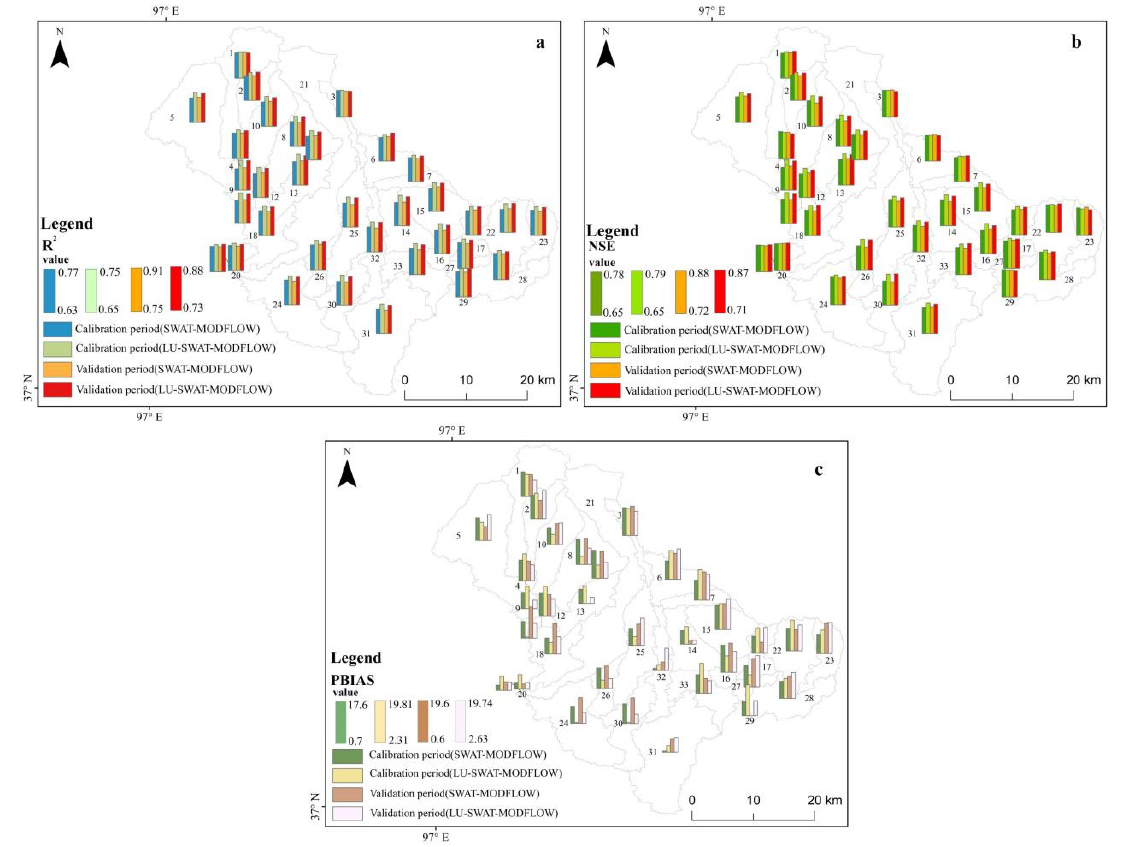
Figure 11. NSE ( a ), R 2 ( b ), PBIAS ( c ) of the calibrated original SWAT-MODFLOW model versus the calibrated LU-SWAT- MODFLOW model in simulating evapotranspiration in each sub-basin.